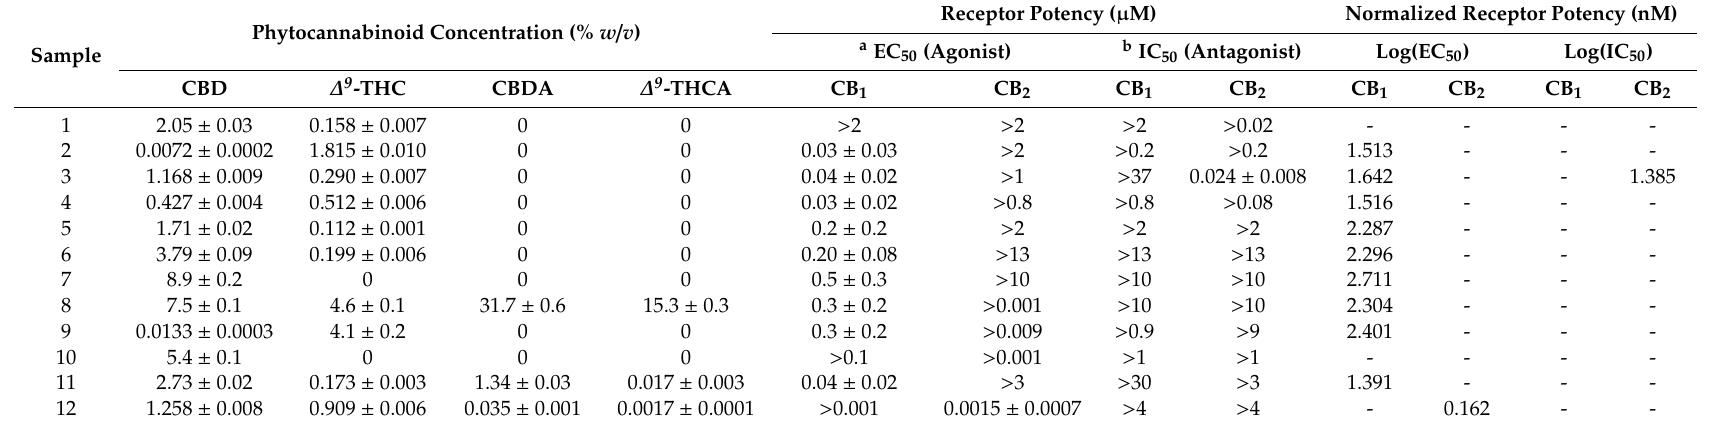
Table 2. Phytocannabinoid concentrations and corresponding receptor potencies of cannabis oil